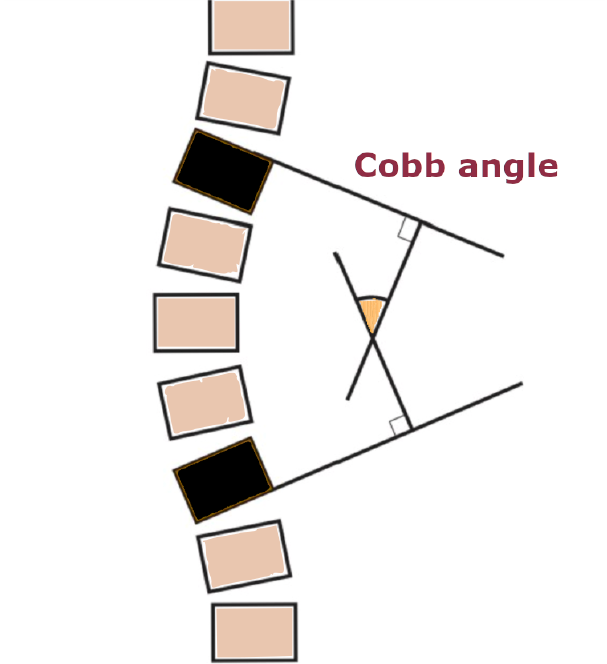
Figure 1. Quantification of scoliosis grade using the Cobb